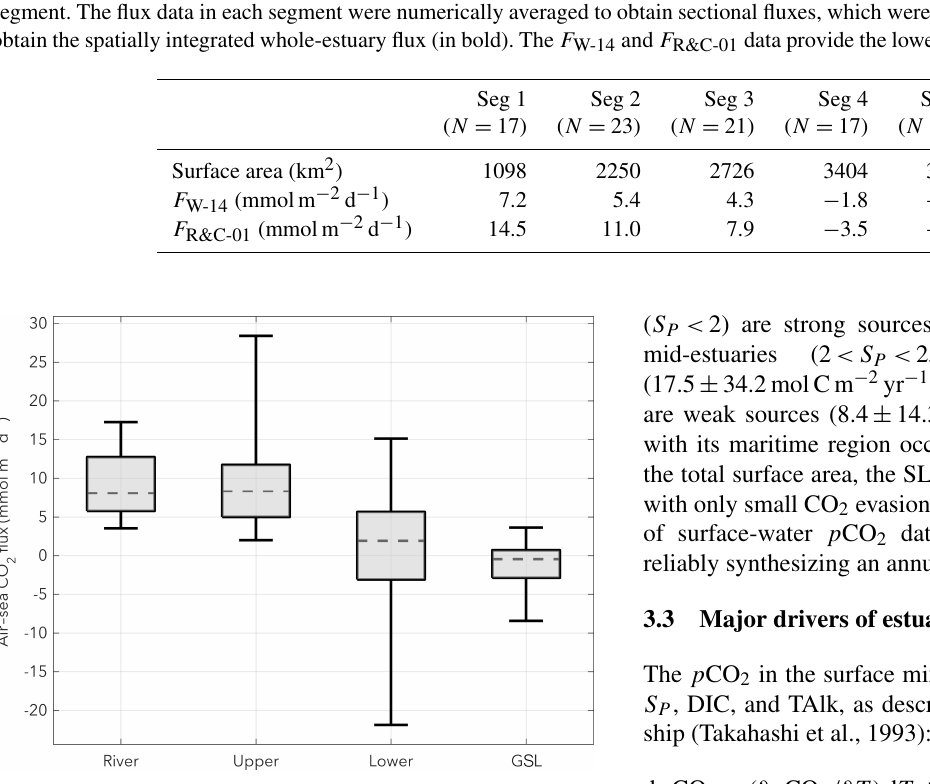
Figure 7. Box plot showing the variability in air–sea CO 2 fluxes in the four principal subdivisions of the study area (St. Lawrence River, USLE, LSLE, and GSL). The box spans the interquartile range (25–75 percentiles), the dashed line is the median, and the whiskers extend to the extreme data points. The F W-14 data were combined with the F R&C-01 data from all spring and summer sam- pling months to depict the upper and lower limits of gas